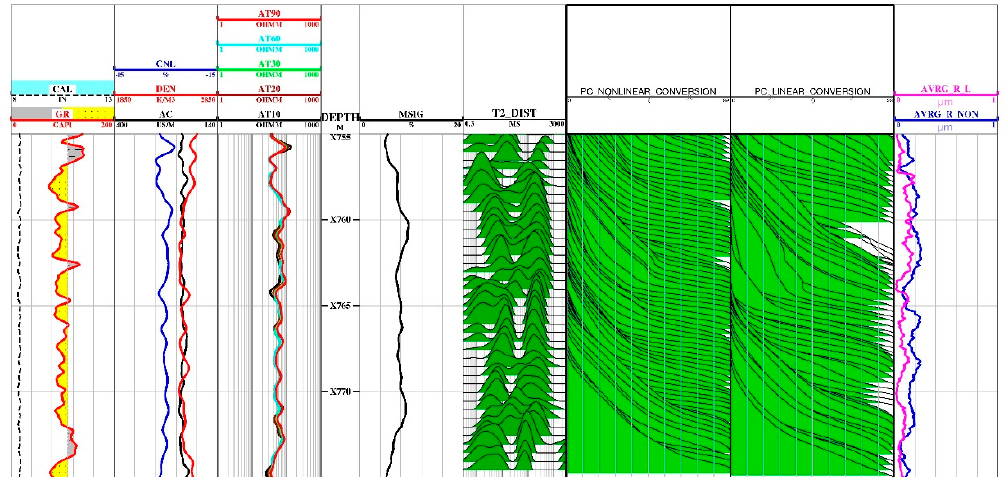
Figure 14. Comparisons of linear conversion results and nonlinear conversion results for a well from 301 the Ordos Basin, China. 302